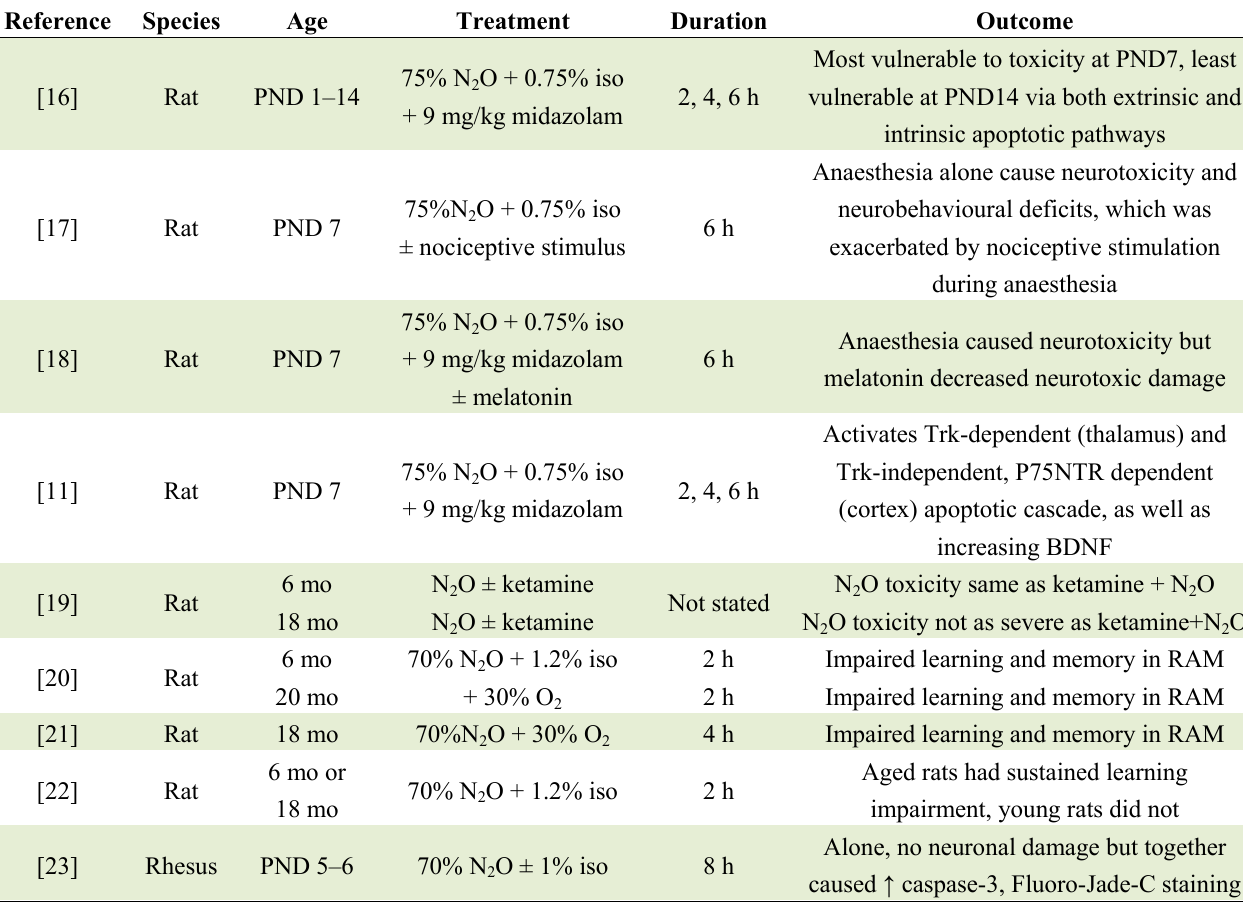
Table 1. An outline of major in vivo studies, regarding the neurotoxicity and mechanisms of nitrous oxide in combination with other anaesthetics, spanning the past 25 years. The studies cover a wide range of ages, anaesthetic concentrations, duration of anaesthesia